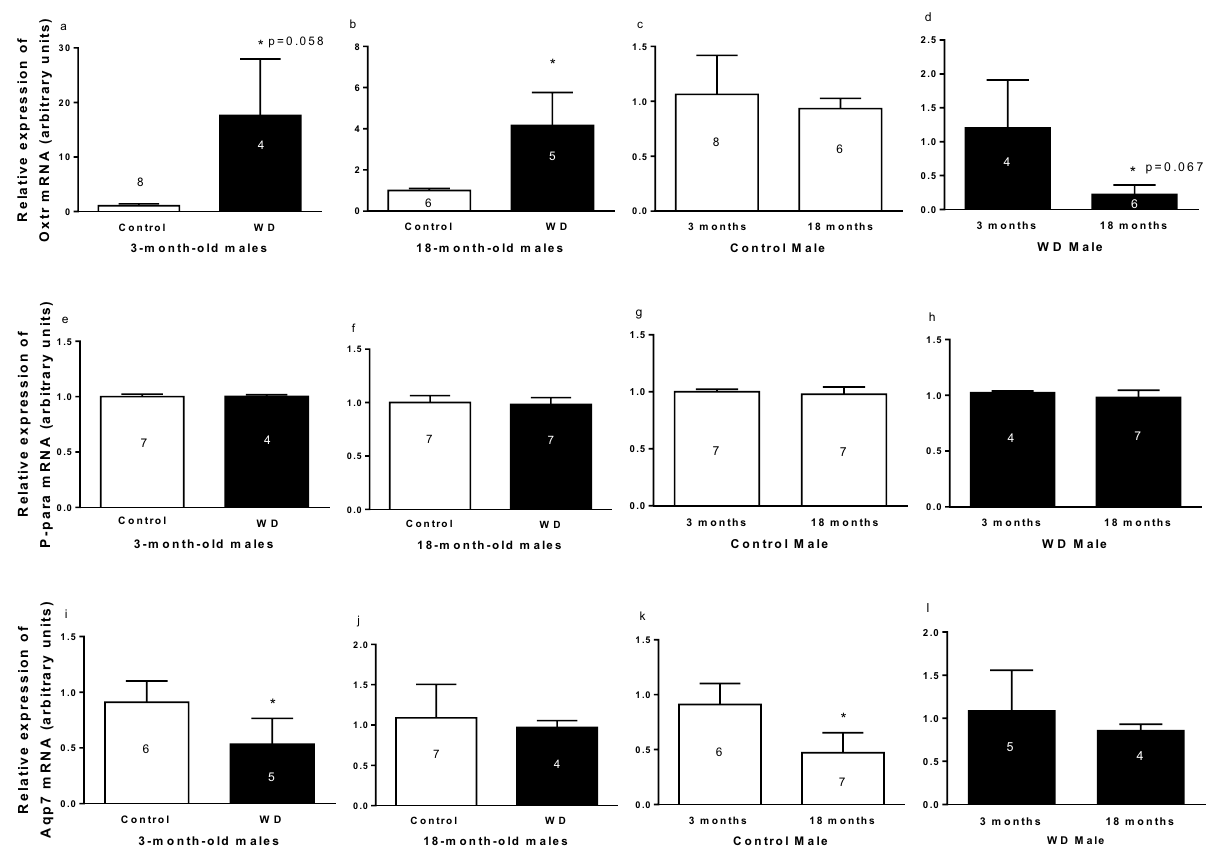
Figure 3. Relative expression of Oxtr ( a – d ), Ppara ( e – h ) , and Aqp7 ( i – l ) mRNA in R-WAT of 3- and 18-month- old control and with water deprivation (WD) male rats. Comparison by hydration condition ( a and b ; e and f ; i and j ), age ( c and d ; g and h ; k and l ). Data are presented as means (SD), *p < 0.05 with respect to control ( a , b , and i ), 3-month-old ( d and k ). Student’s unpaired t-test. The n for each group is inside or above the